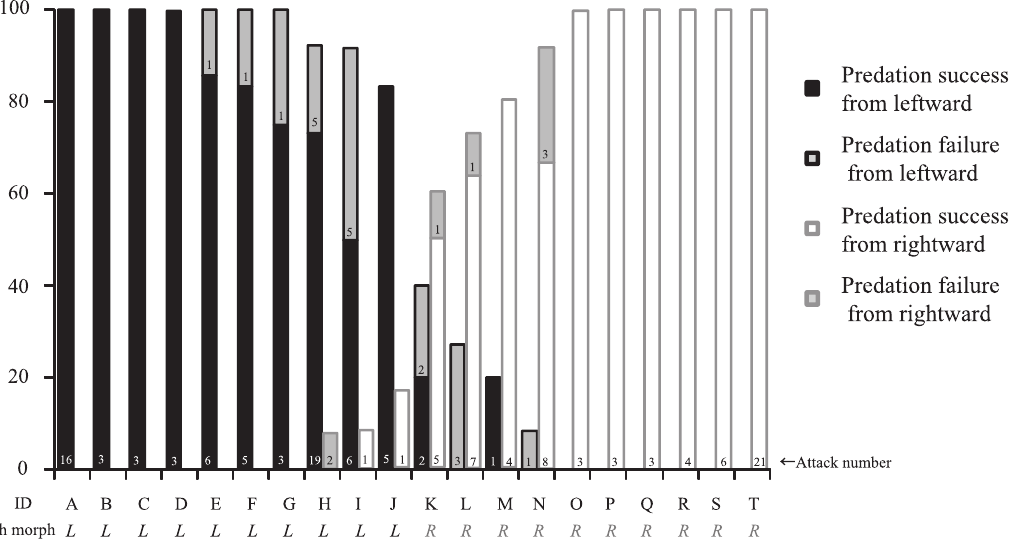
Figure 2. Percentage of left-side (black column) and right-side (open column) attacks for each predator (N=20). Grey columns indicate failed attempts at scale eating. The numbers at the bottoms of the columns indicate the number of attacks by each fish. Asymmetric mouth morphology, lefty ( L ) or righty ( R ), is denoted for each fish. No lateral bias was observed in J, K, or L.